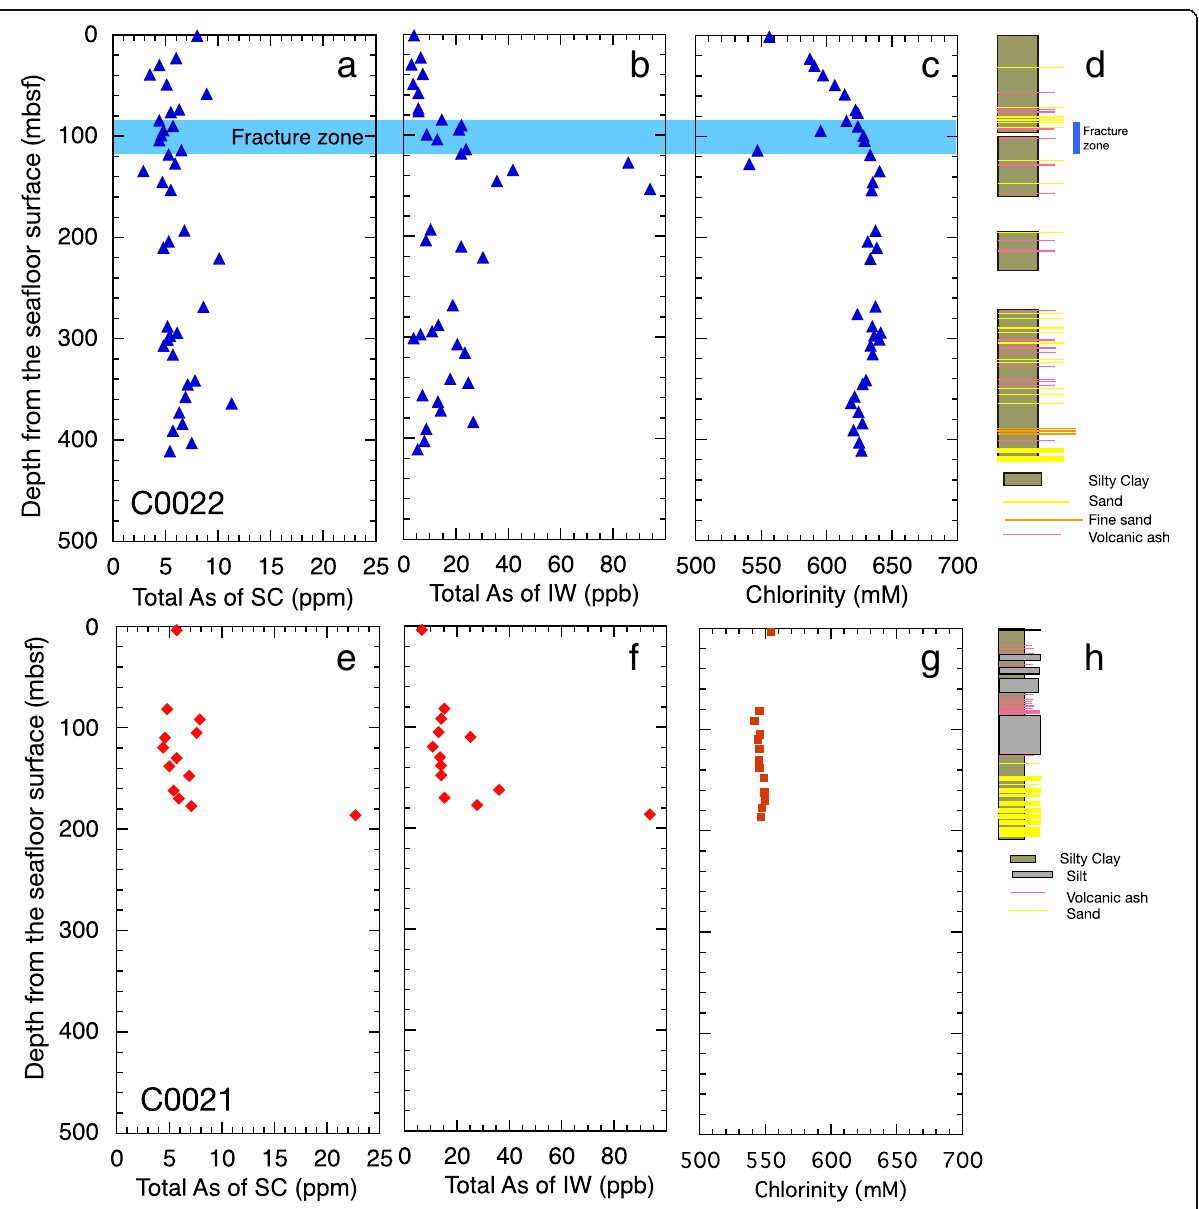
Fig. 3 Arsenic concentrations of sediment (squeezed cake) and interstitial water and chlorinity of Sites C0021 and C0022, Kumano Basin, Nankai Trough, in relation to the depth, lithology and its related components ( a ) ( b ) ( c ) ( d ): Arsenic concentrations of sediment and interstitial water, chlorinity and lithology of Site C0022. ( e ) ( f ) ( g ) ( h ): Arsenic concentrations of sediment and interstitial water, chlorinity and lithology of